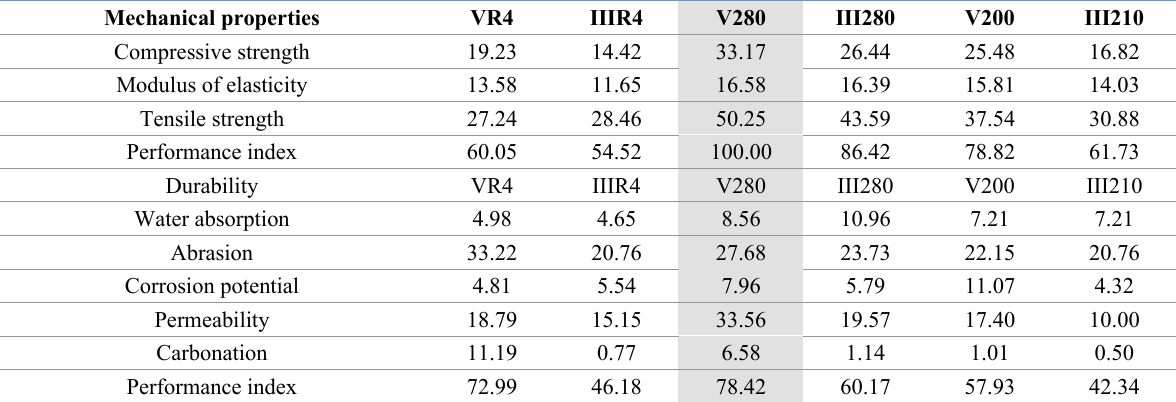
Table 8. Performance index of mechanical properties and durability (Scenario 1 - Industrial floor). Mechanical properties